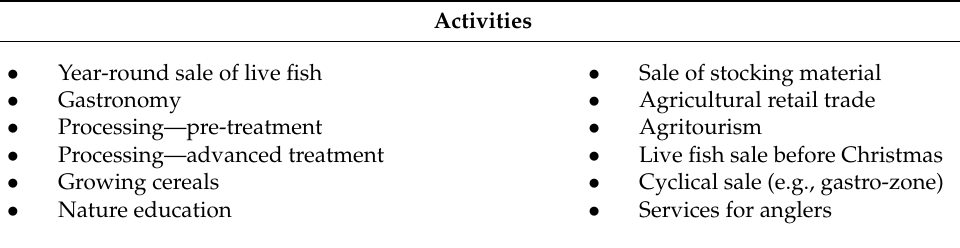
Table 6. Diversification of the fish farms